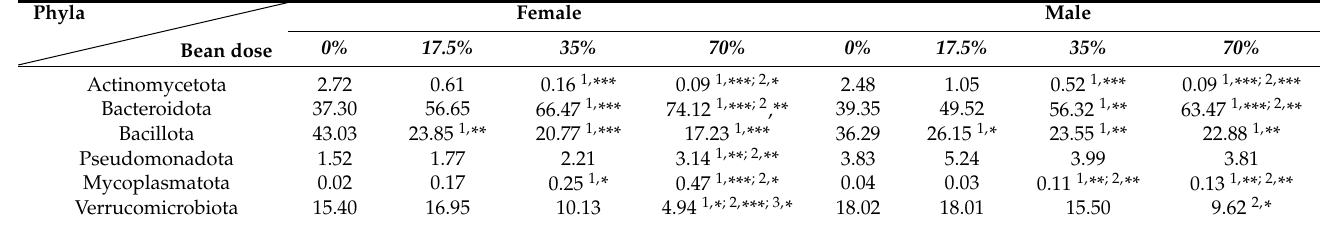
Table 2. Relative abundances of phyla per each sex cohort and diet group.